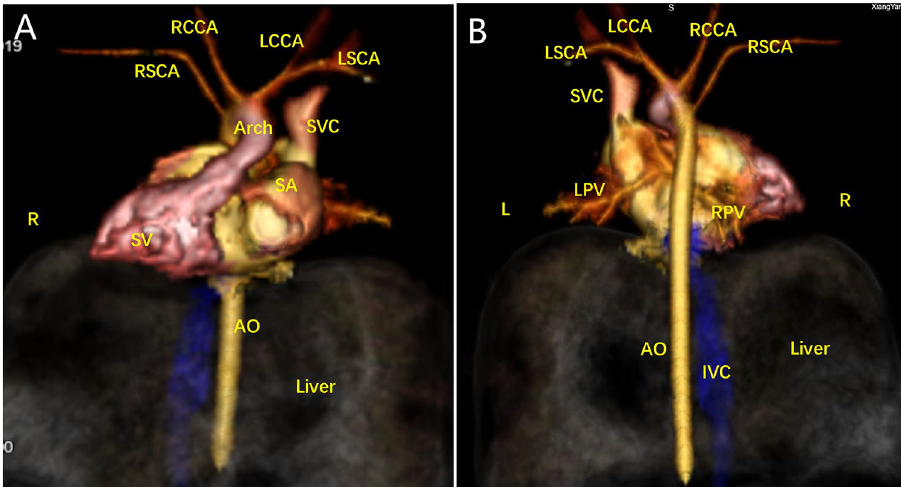
Figure 2. Postpartum CTA findings. ( A – F ) CTA revealed dextrocardia, a single ventricle, isolated left superior vena cava, right aortic arch with mirror branches, and left and right PVs returning to the left superior vena cava via vertical veins. AO ascending aorta, IVC inferior vena cava, LCCA left common carotid artery, LSCA left subclavian artery, RCCA right common carotid artery, RSCA right subclavian artery, SA single atrium, SV single ventricle.